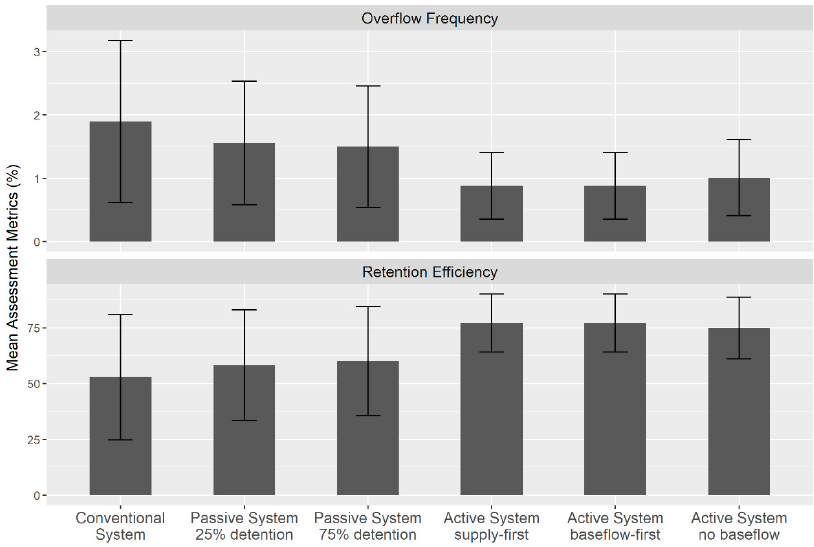
Figure 4. Mean value (bar) and associated standard deviation (error bar) for overflow frequency and retention efficiency in the six system configurations. Overflow frequency and retention efficiency are expressed as percentages.